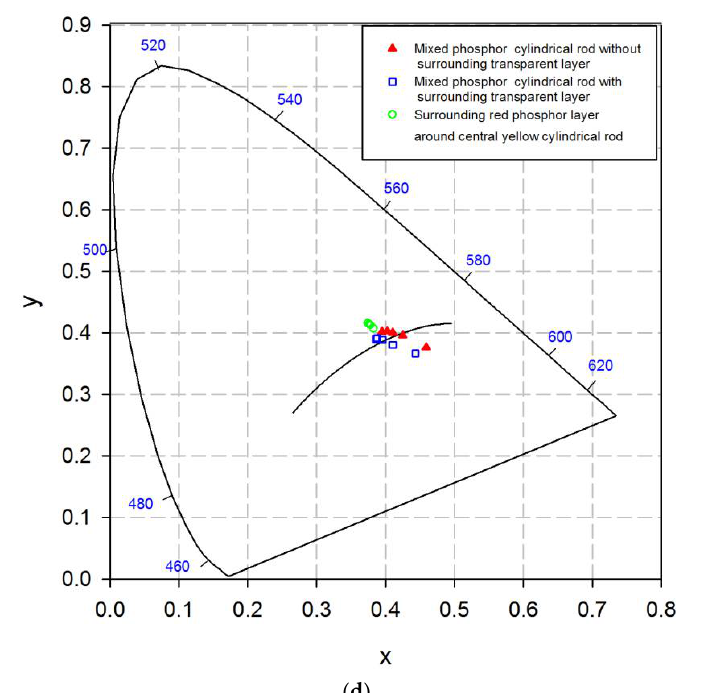
Figure 5. Emission spectra of ( a ) cylindrical rod containing both yellow and red phosphors with- out surrounding transparent layer, ( b ) cylindrical rod containing both yellow and red phosphors with surrounding transparent layer, and ( c ) surrounding red phosphor layer around central yellow cylindrical rod for laser-driven white lighting. ( d ) CIE chromaticity coordinates of all the samples containing both yellow and red phosphors in this study.